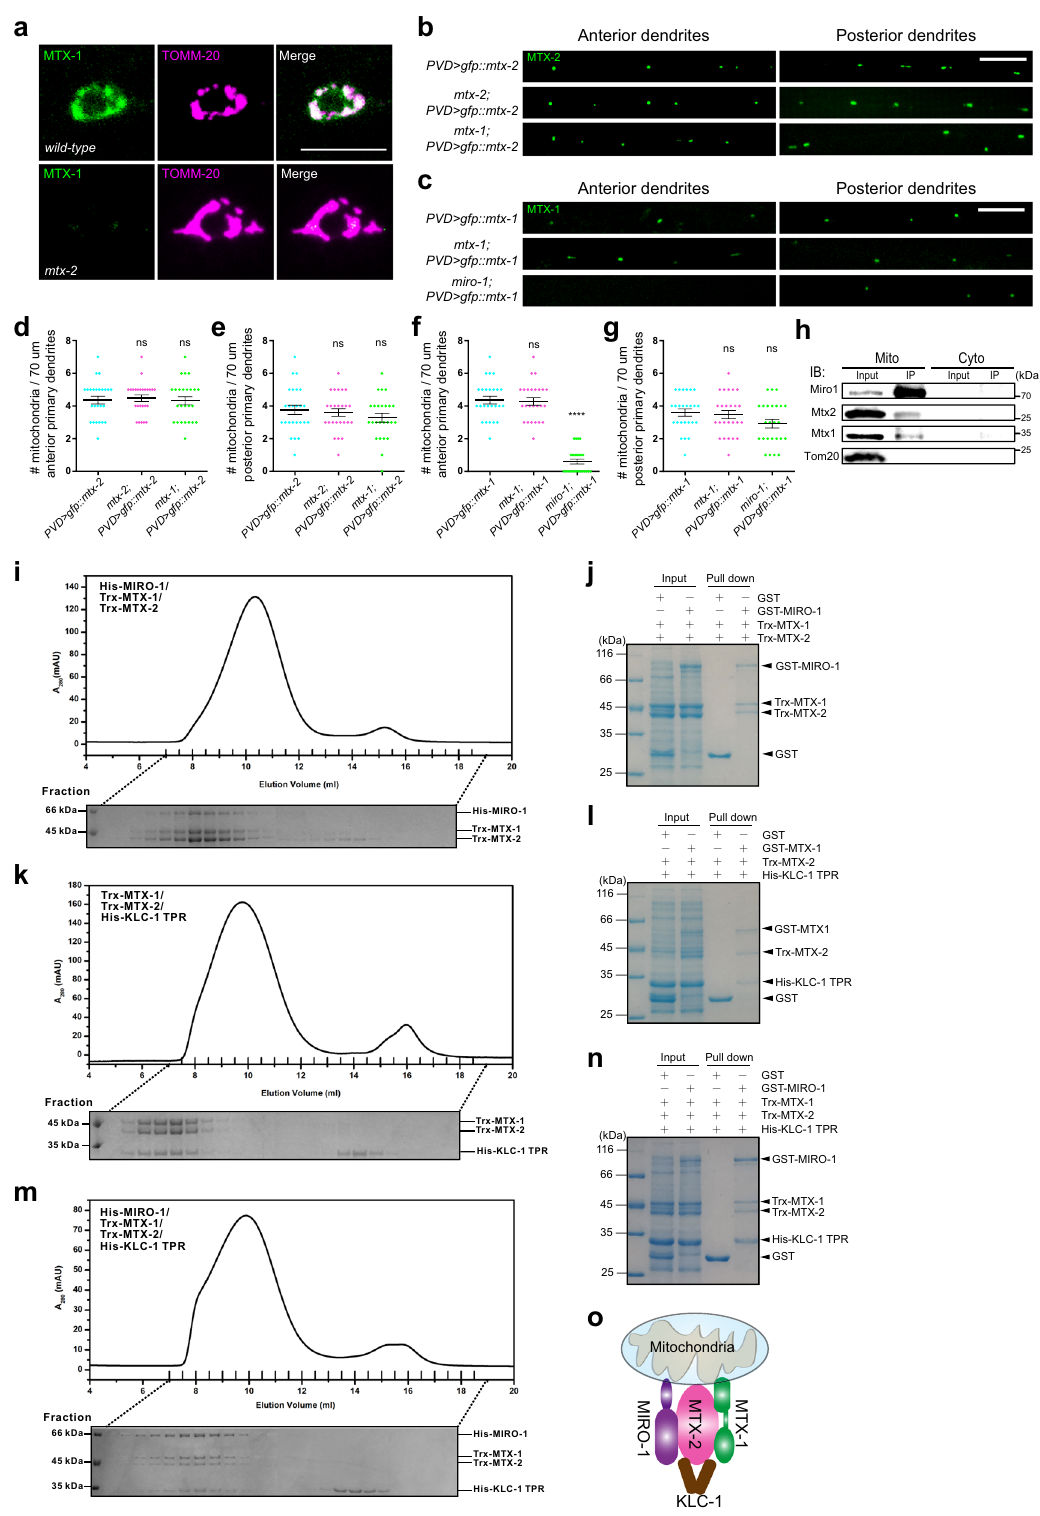
1/TRAK-1 are indispensable for coupling mitochondria to dynein. Impairment of mitochondrial traf fi cking leads to dendrite degeneration . Mitochondria play a pivotal role in neuronal function by producing ATP and buffering intracellular calcium.